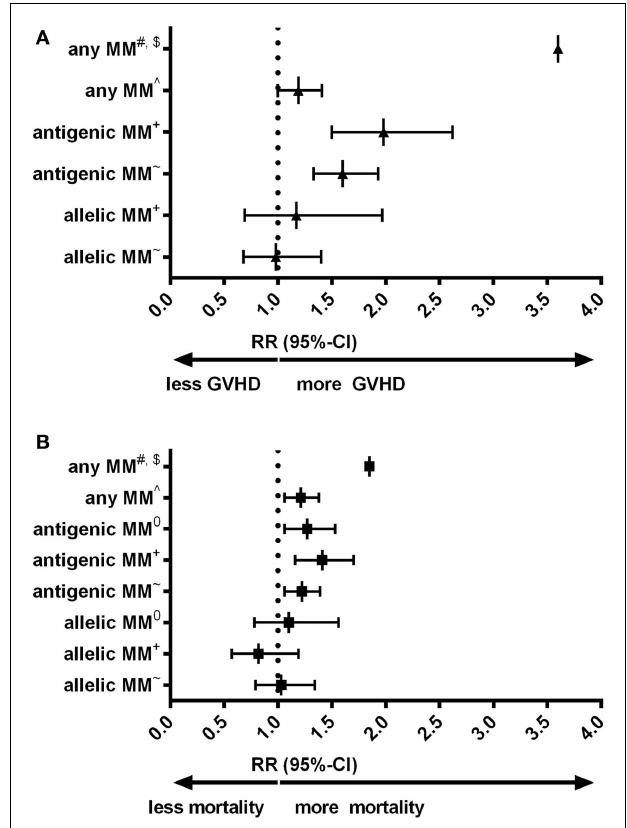
FIGURE 1 | (A) Forest plot for relative risk of acute GVHD III-IV of HLA-C mismatches compared to HLA-matched transplants. (B) Forest plot for relative risk of mortality of HLA-C mismatches compared to HLA-matched transplants. # : (10) 33 cases of an HLA-C mismatch (either allelic or antigenic, also in combination with other mismatched loci) were compared to 78 10/10 matches. $ : Authors indicated hazard ratios. ∧ : (11) 749 HLA-C mismatches (either allelic or antigenic) were compared to 108 8/8 matches. + : (9) 189 HLA-C antigenic mismatches and 61 HLA-C allelic mismatches were compared to 1243 8/8 matches. ~: (12) 382 HLA-C antigenic mismatches and 96 HLA-C allelic mismatches were compared to 1840 8/8 matches. 0 : (13) 300 HLA-C antigenic and 57 HLA-C allelic mismatches were compared to 1511 10/10 matches. 10/10 match: donor and recipient matched on high-resolution level for HLA-A, -B, -C, -DRB1, and -DQB1. 8/8 match: donor and recipient matched on high-resolution level for HLA-A, -B, -C, and -DRB1. MM: mismatch. RR: relative risk, relative to either 8/8 or 10/10 matches, as indicated.